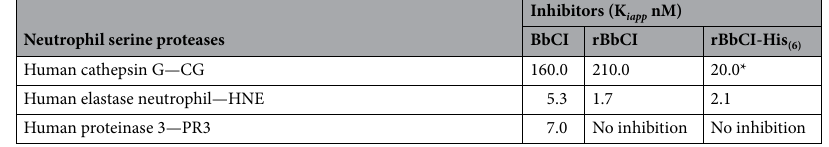
Table 1. Studies of the inhibitory action of BbCI and its recombinant form on neutrophil enzymes. Data are expressed as mean and * p ˂ 0.05, versus the corresponding Kiapp values of rBbCI was considered significant.